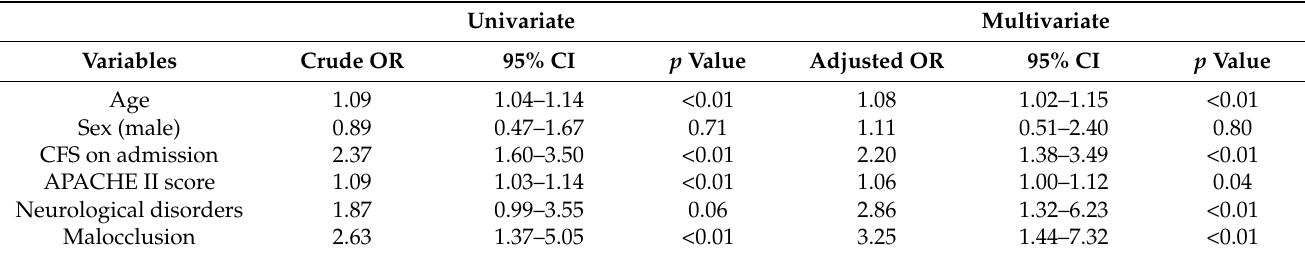
Table 4. Univariate and multivariate analyses for ADL loss of the study population 65 years and older.